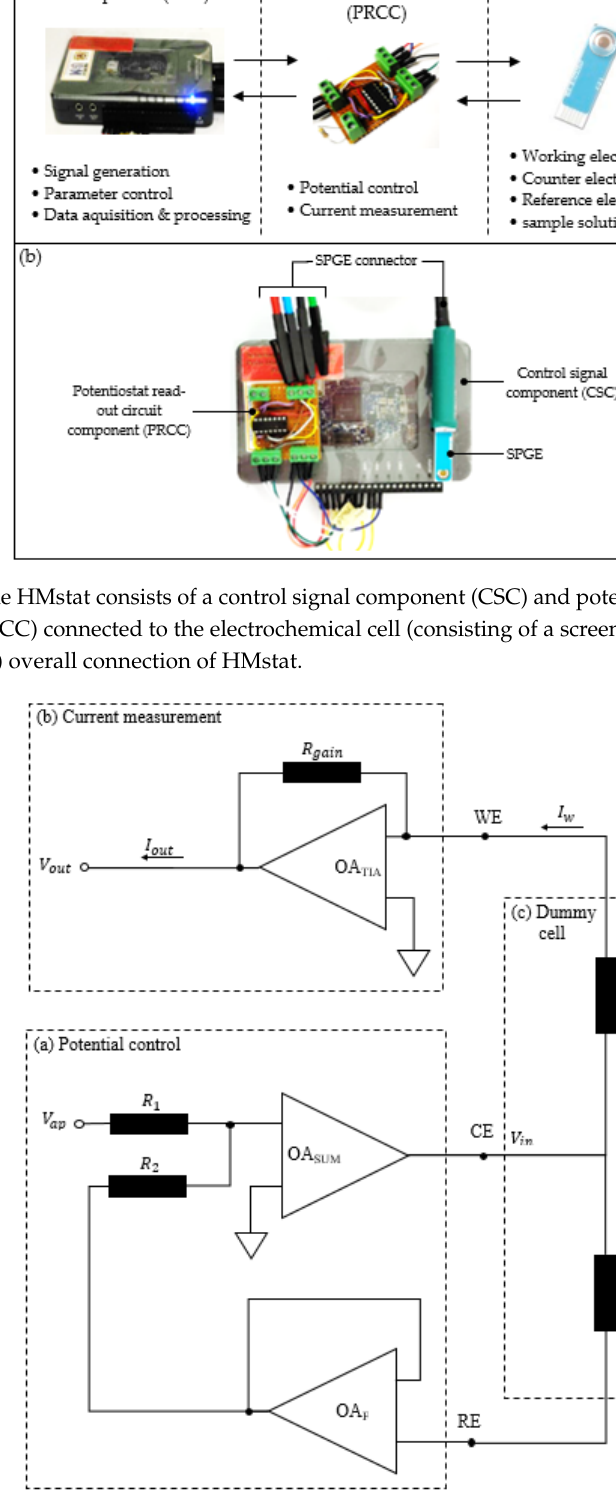
Figure 2. Block diagram of the potentiostat read-out circuit component (PRCC) comprised of ( a ) potential control part (PCP) and ( b ) current measurement part (CMP), connected to a ( c ) dummy cell (for accuracy and noise measurement).